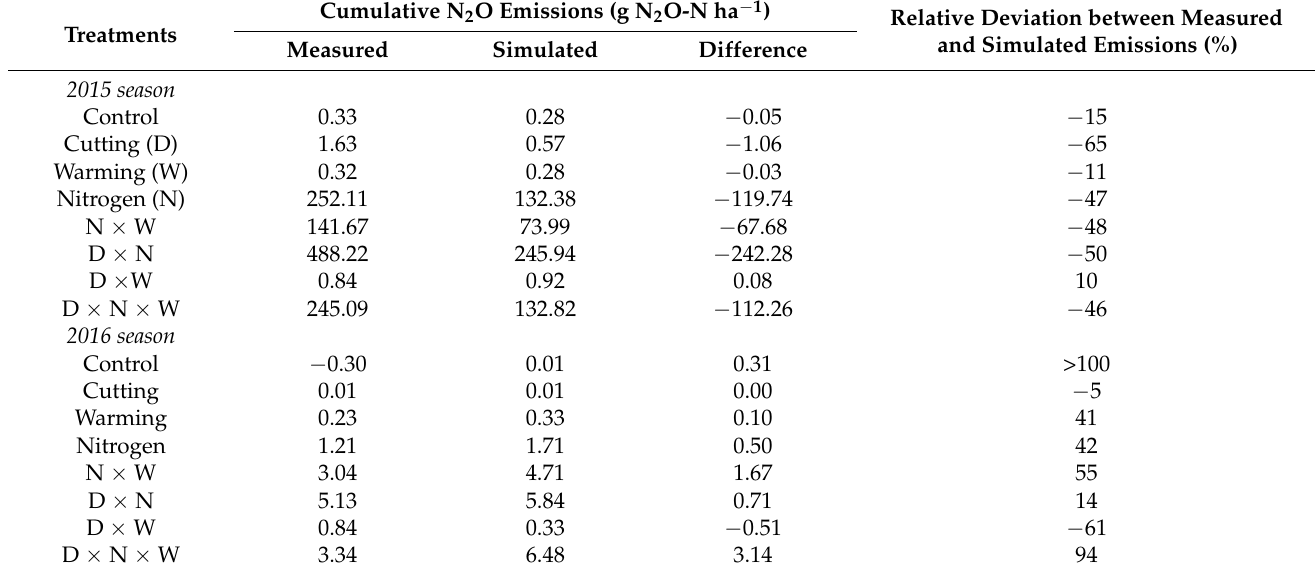
Table 2. Measured and DNDC-simulated cumulative N 2 O emissions (g N 2 O-N ha − 1 ) for the full factorial experiment over two growing seasons (2015 and 2016).